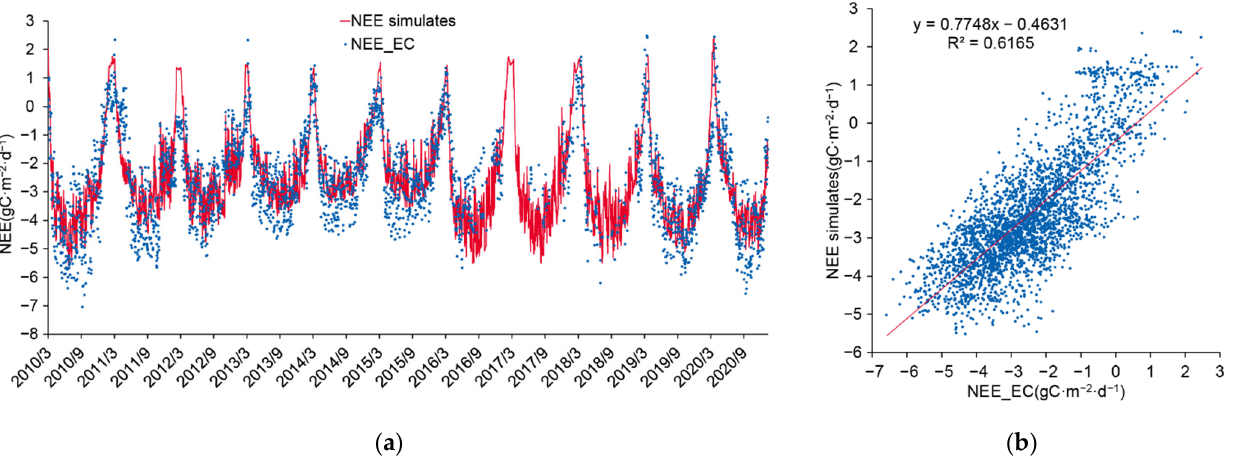
Figure 4. ( a ) Curve chart and ( b ) scatterplot of validation of NEE values simulated from the calibrated Biome-BGC model during 2010–2020.